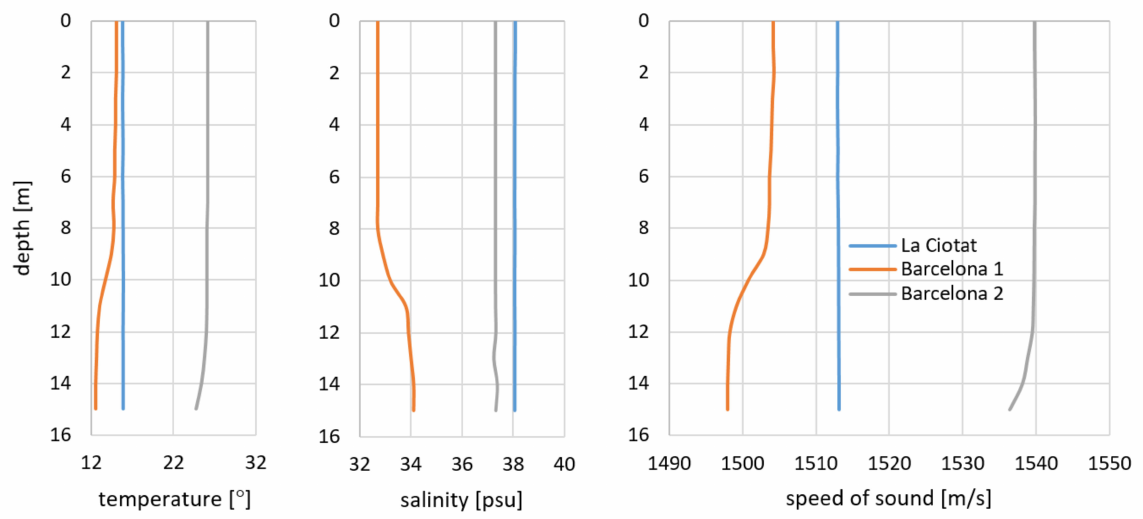
Figure 13. Temperature, salinity and sound speed in water profiles in the Mediterranean